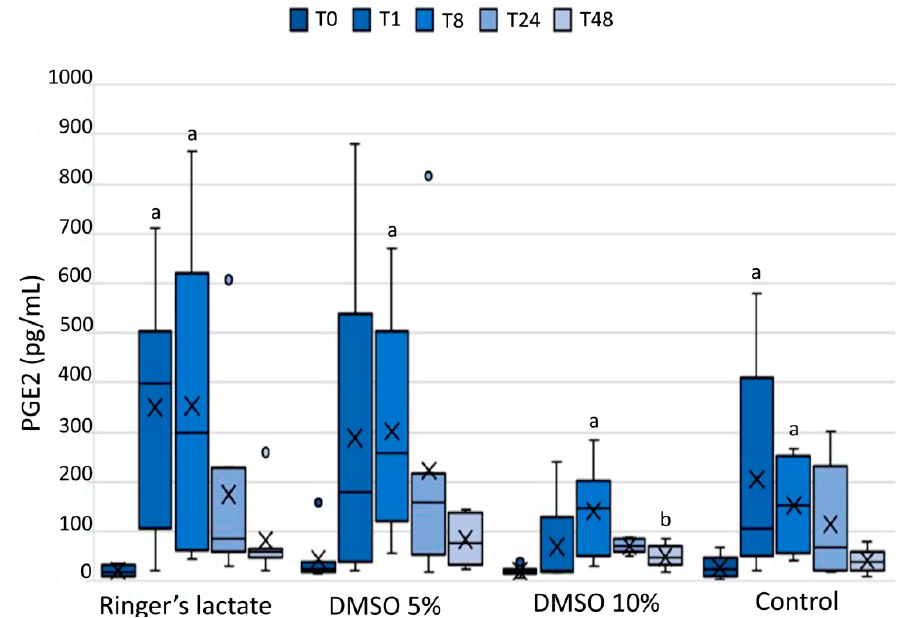
Figure 2. Prostaglandin E2 (PGE2) concentration (pg / mL) in the synovial fluid. PGE2 concentrations are shown as box plots, indicating the median ( − ), mean ( × ), and first and third quartiles. a Statistically significant di ff erences compared to the baseline values ( p < 0.05); b Statistically significant di ff erences compared to T8 ( p < 0.05).